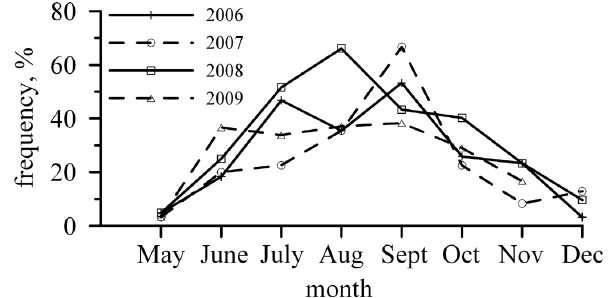
Fig. 3. Monthly frequency of cases with correlation between daily SST and wind speed more or equal 0.5 for May–December 2006– 2009 in the area limited in co-ordinates 54 ◦ 30 0 N–56 ◦ 30 0 N and 144 ◦ 15 0 E–147 ◦ 15 0